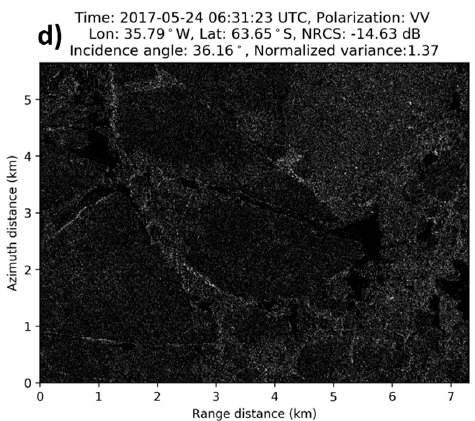
Figure 1. Examples of Gaofen-3 Wave Mode (GF-3 WM) imagettes (in VV polarization) with clear swell pattern ( a ) and data rejected owing to ( b ) inhomogeneous; ( c ) invisible swell features, and ( d ) high-latitude sea-ice covering imagettes.